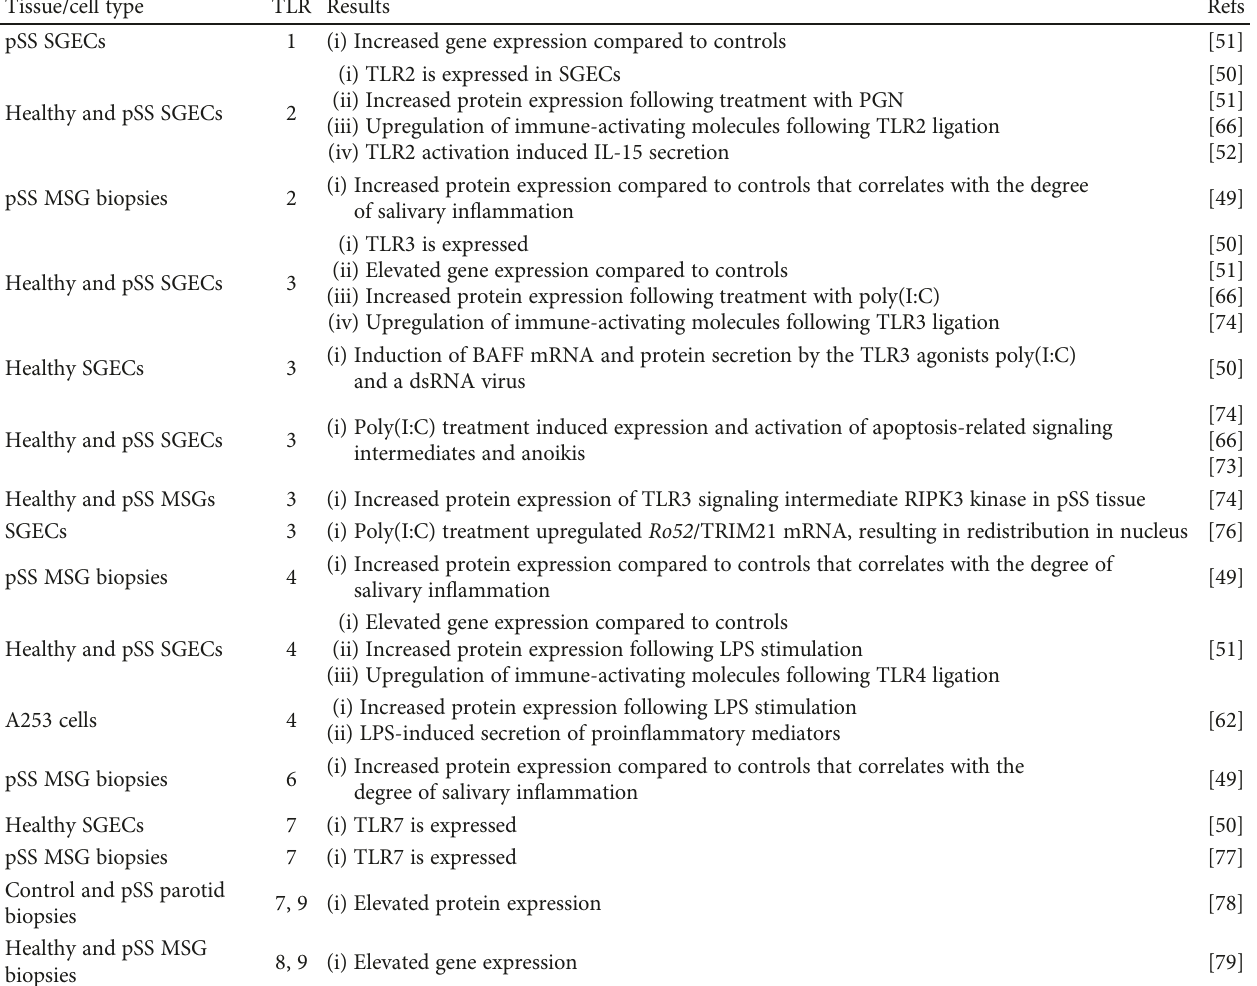
Table 2: Aberrant TLR expression and activation in salivary tissue in